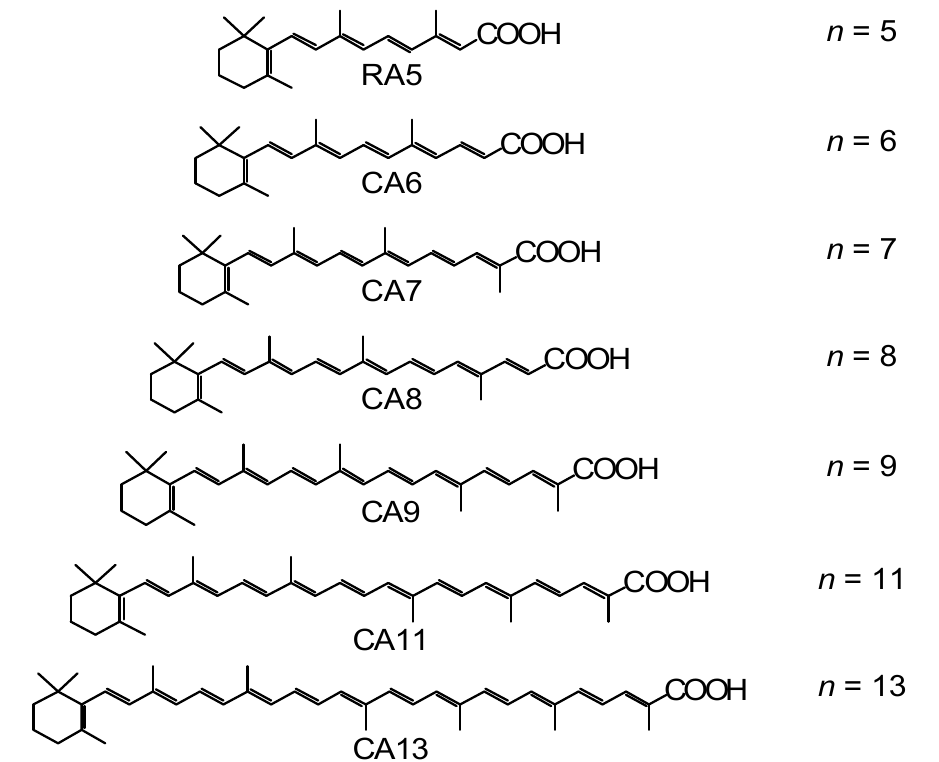
Figure 1. Chemical structures of retinoic acid (RA5) and carotenoic acids (CA6–CA13) having n = 5–13 conjugated double bonds.